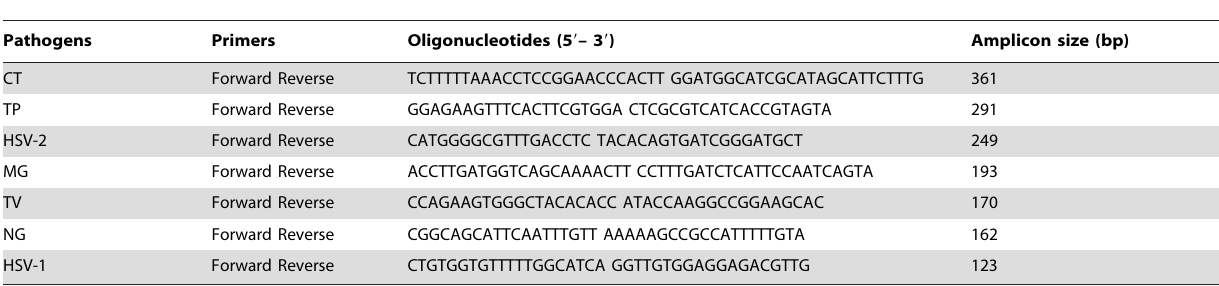
Table 1. Oligonucleotide primers used in the M–PCR assay.